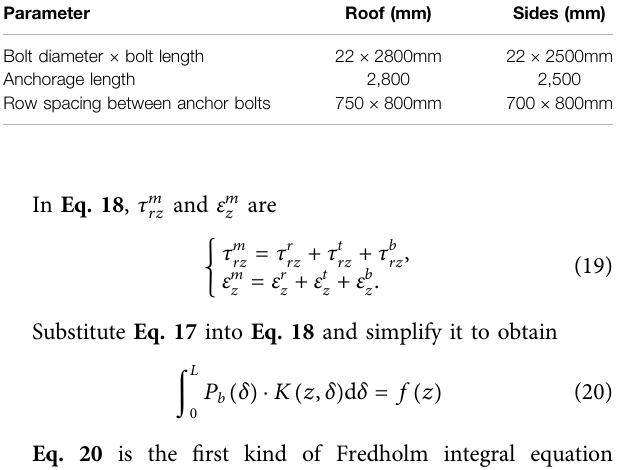
Figure 6 . At this time, the surrounding rock is supported by the